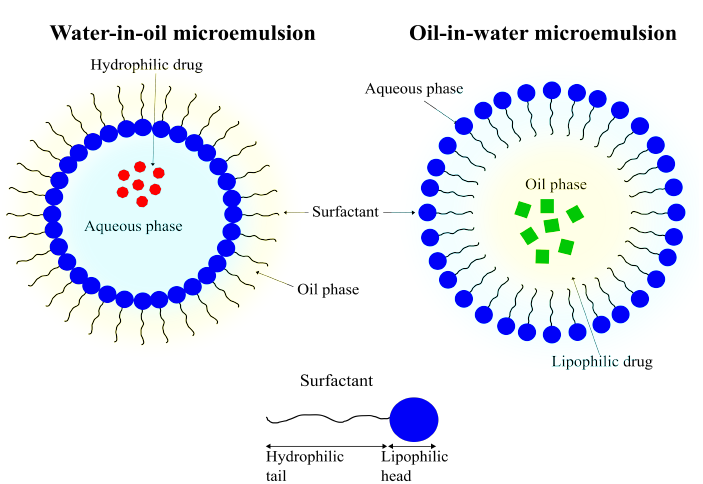
Figure 11. A schematic representation of a water-in-oil microemulsion droplet with a hydrophilic drug entrapped in its aqueous core (left) and an oil-in-water microemulsion droplet with a lipophilic drug encapsulated in the organic